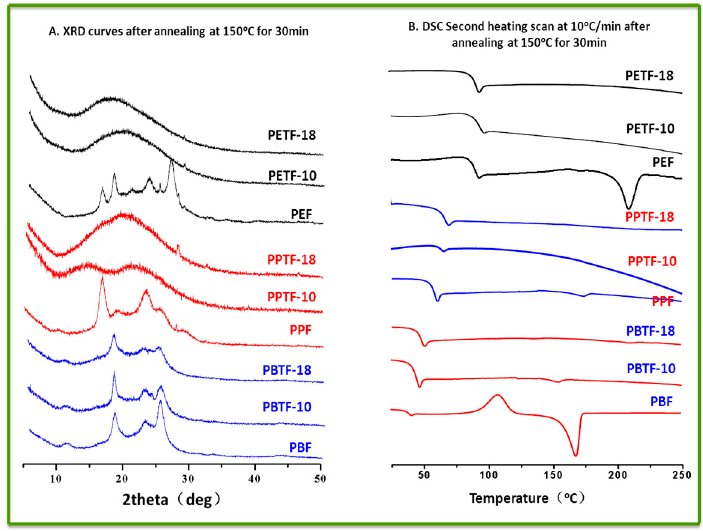
Figure 4. XRD and DSC curves for PEF, PPF, PBF, and their copolyesters after being annealed at 150 °C for 30 min.